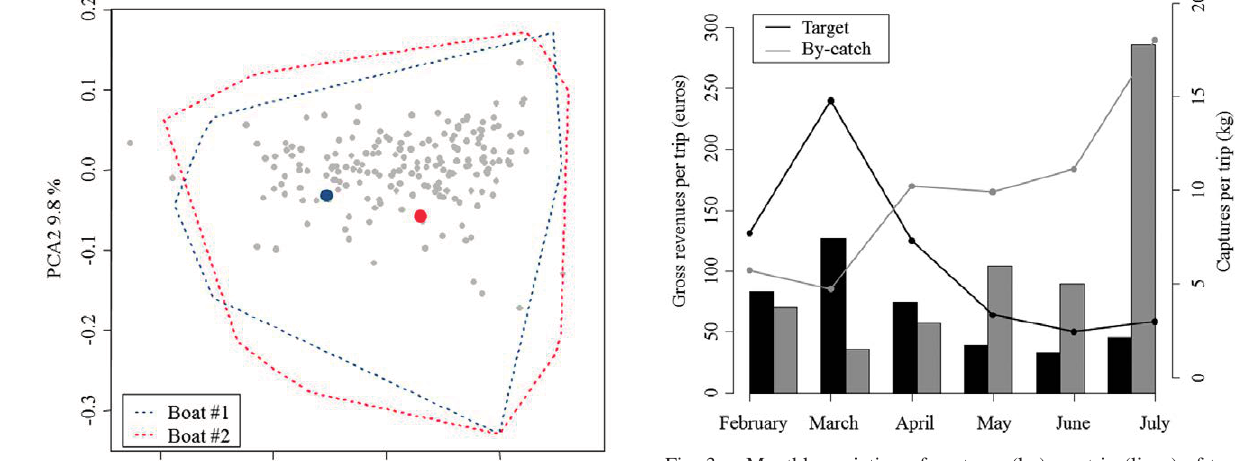
(B).Fig. 3. – Monthly variation of captures (kg) per trip (lines) of tar- geted and untargeted commercial captures and gross revenues in euros (bars) obtained from the sale of these Fig. 1. – PCA plot of landed commercial captures (kg of each com- mercial category) for all the (daily) fishing trips of the cuttlefish trammel net fleet from Mallorca during the period 2015-2017. The grey points denote the average scores for all the boats (i.e. centroid) and the larger, coloured points denote the sampled boats. For these two boats, the envelope polygon including all the fishing trips of each boat is also indicated.